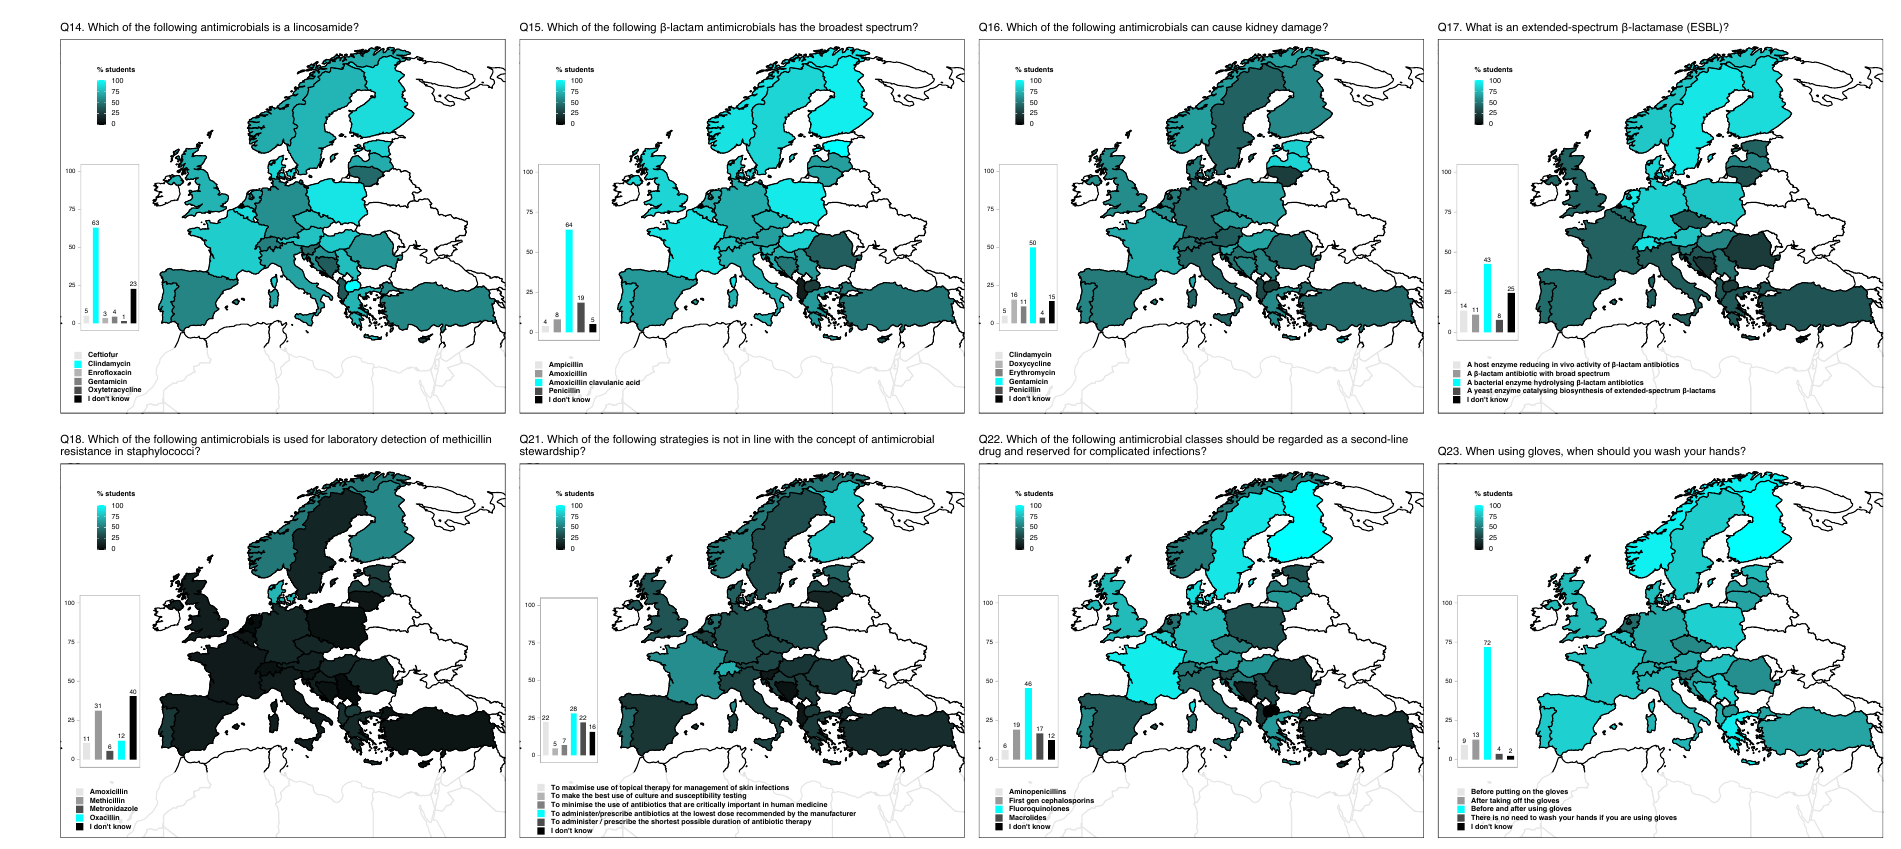
Figure 2. Percentage of final-year veterinary students selecting the correct answer to questions related to antimicrobial agents and infection control in veterinary medicine. Q17 should be interpreted carefully in Austria, Germany, and Switzerland due to an error in the German-language version of the survey (two correct options for German-speaking students instead of one). Bar plots show the percentage of students selecting each of the answers available (bottom legends), and correct answers are assigned the cyan colour. Maps display the percentage of students that selected the correct answer (top-left legends). Bar plots may display added percentages above or below 100% due to rounding of the